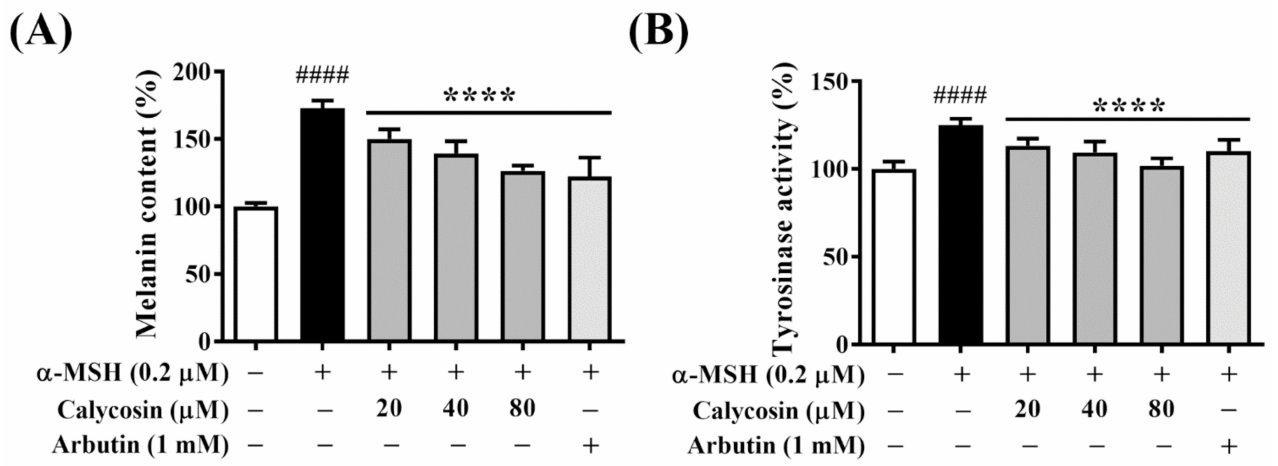
Figure 2. Calycosin inhibits melanin content and tyrosinase activity in B16F10 cells. Inhibitory effects of calycosin on ( A ) melanin content (%) and ( B ) tyrosinase activity (%) in B16F10 cells treated with 0.2 µ M α -MSH and indicated concentrations of calycosin for 48 h. Data are represented as the means ± S.D. from three independent experiments. Significant difference versus control: #### p < 0.0001. Significant difference versus α -MSH-treated group: **** p < 0.0001. Positive control: 1 mM